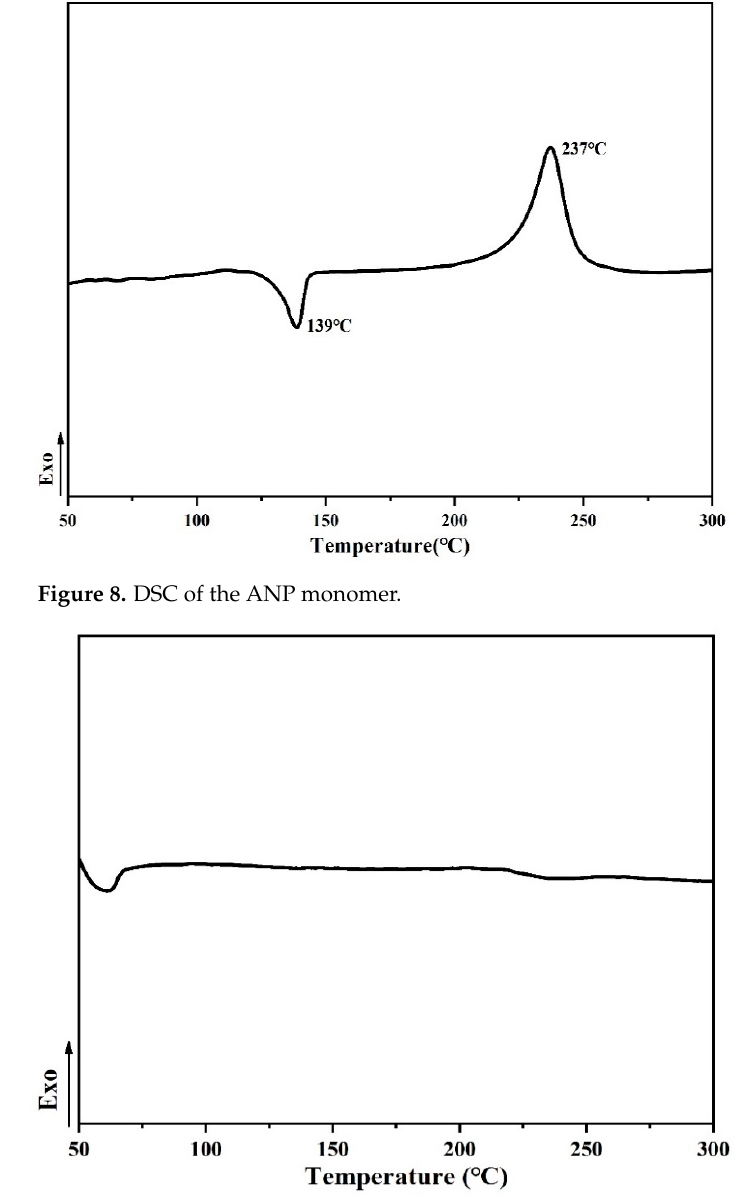
12 of 23 Figure 7. WAXD pattern of DPTP polymers. 3.2. Analysis of Machining Properties The machining properties of the monomer including the T m and processing window analyzed by differential scanning calorimetry (DSC) are shown in Figures 8–10 when the rate of heat addition was 10 °C min − 1 . The difference between T m and curing temperature is defined as the processing window, which has a great influence on the processing prop-